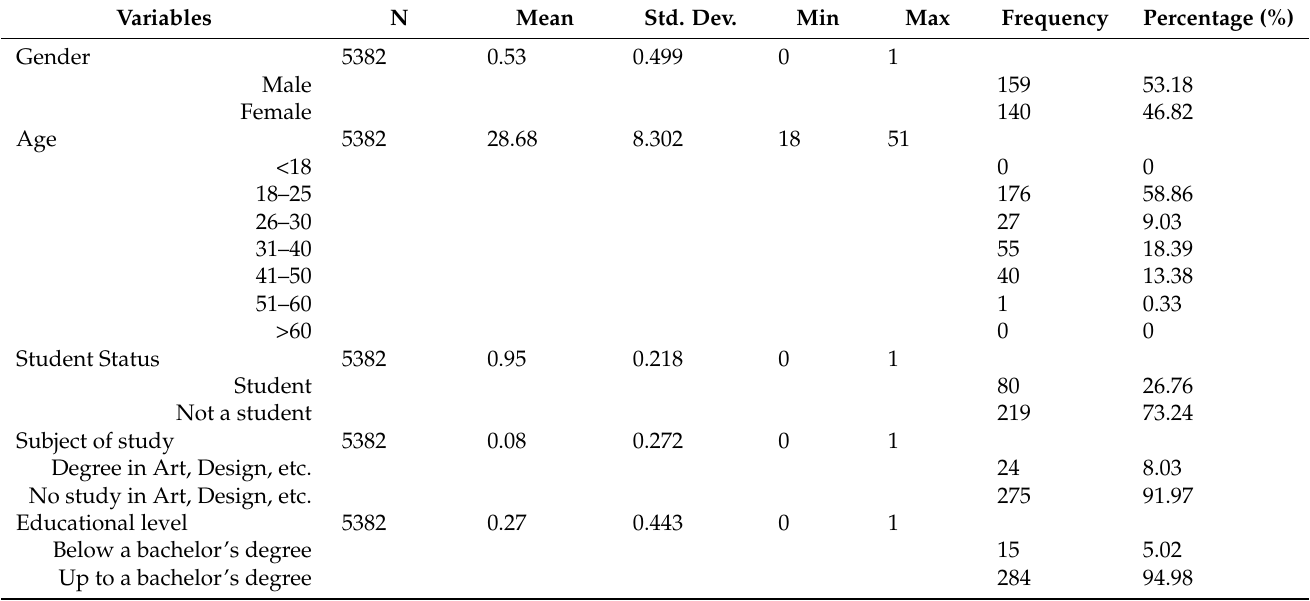
Table 1. Descriptive Statistics.